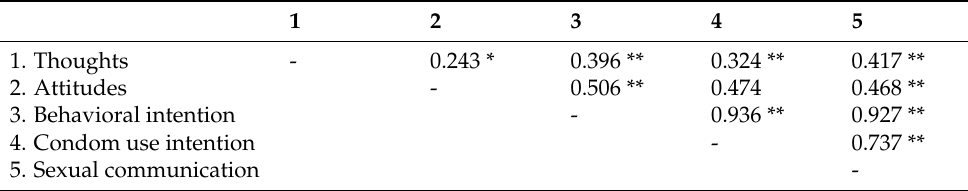
Table 3. Correlations among study variables.